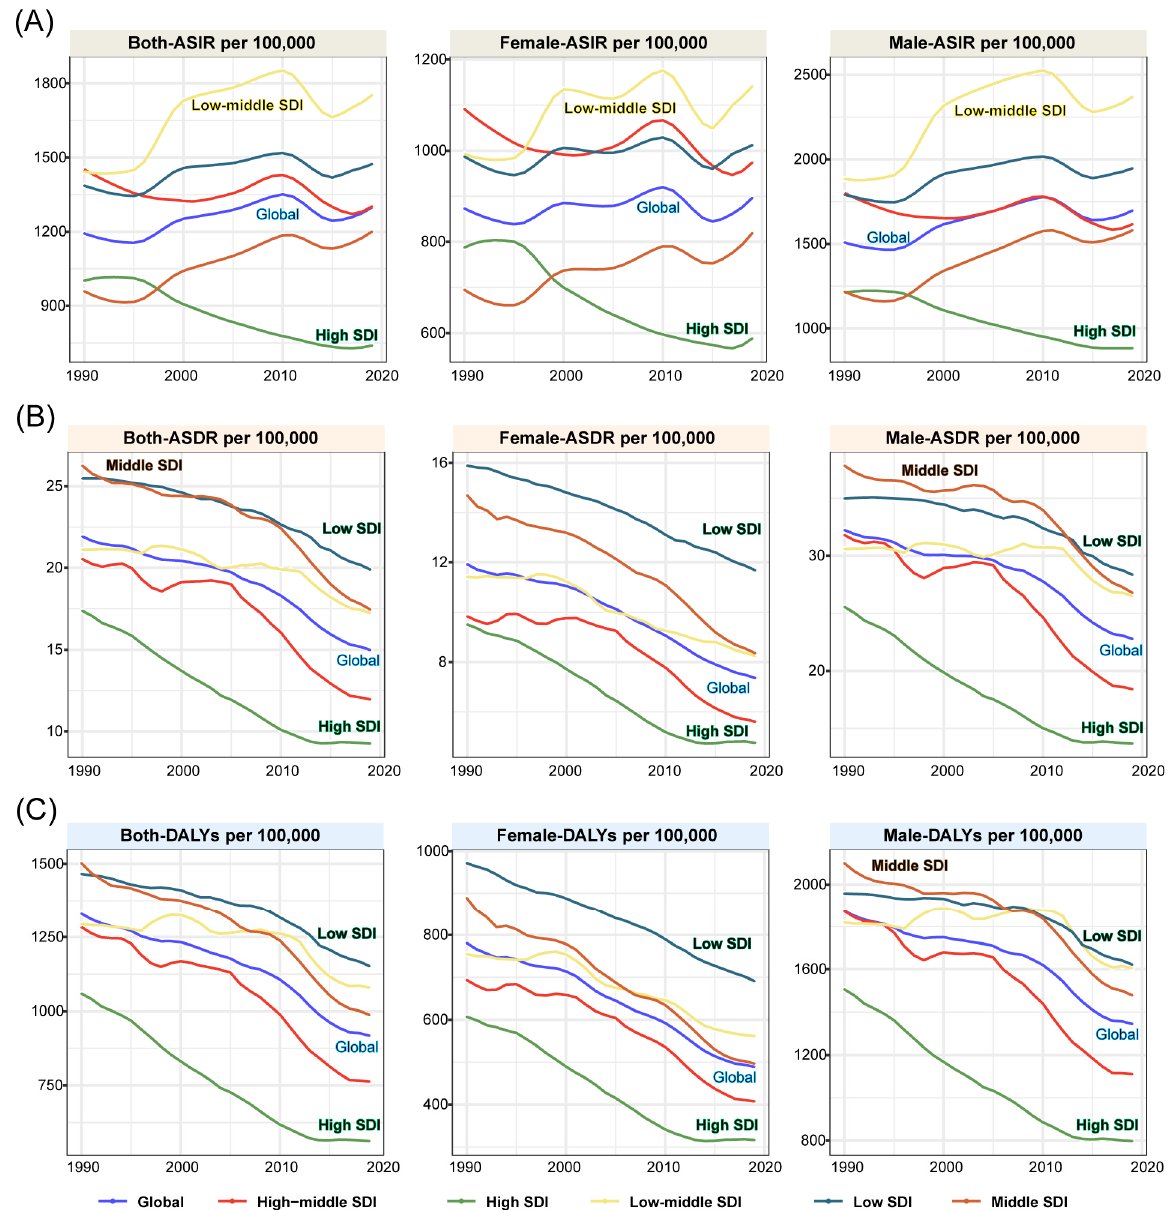
Figure 1. The burden caused by RIs in five SDI regions and globally from 1990 to 2019 in all populations, women, and men and calculated by age-standardized incidence ( A ), deaths ( B ), and DALYs ( C ).